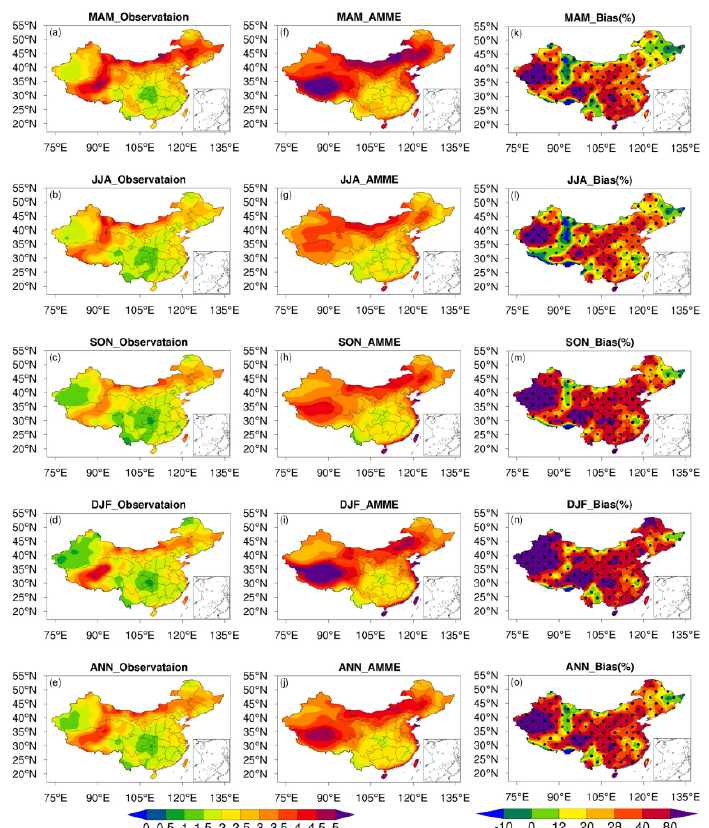
Figure 2. Spatial distributions of ( a – e ) observed NWS (m · s − 1 ), ( f – j ) AMME simulated NWS (m · s − 1 ), and ( k – o ) AMME simulation biases relative to the observations (i.e., simulation minus observa- tion/observation) for the historical period. Black solid dots represent that the absolute bias passed the 95% significance test.